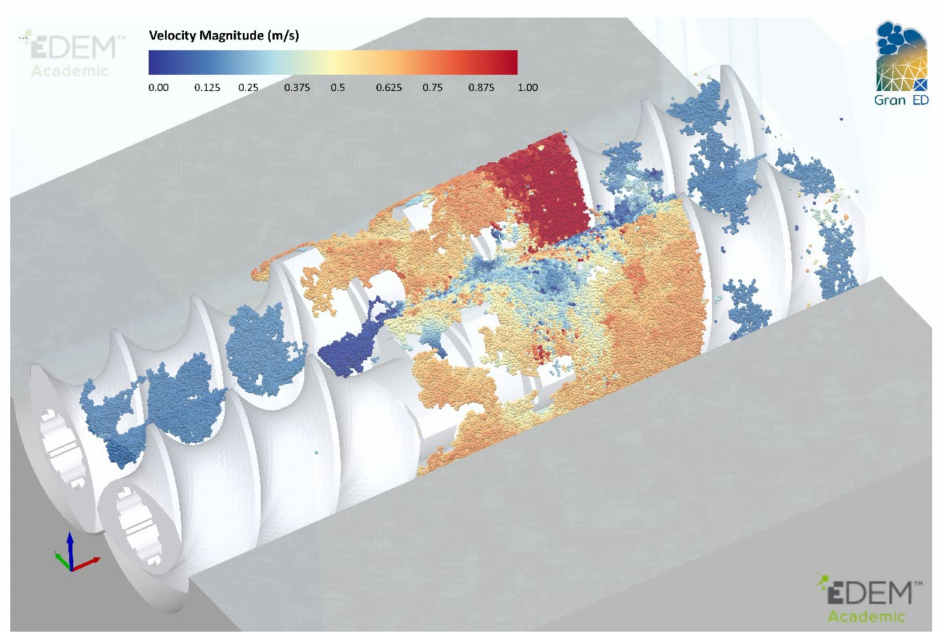
Figure 17. Agglomerate formation in the non-periodic reduced domain model (direction of flow: right to